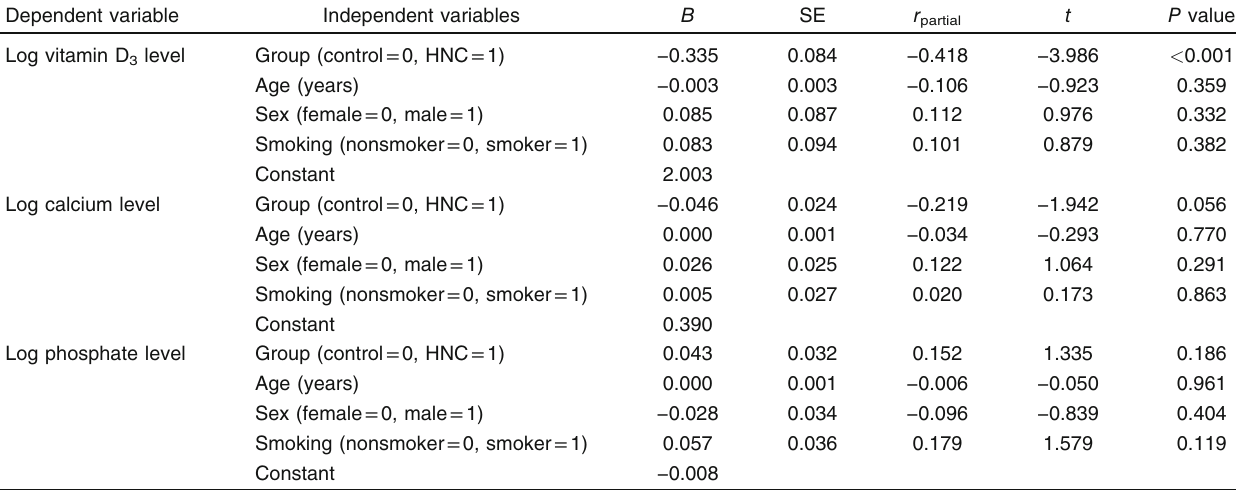
Table 5 Multivariable regression for determinants of vitamin D 3 , calcium, and phosphate levels Dependent